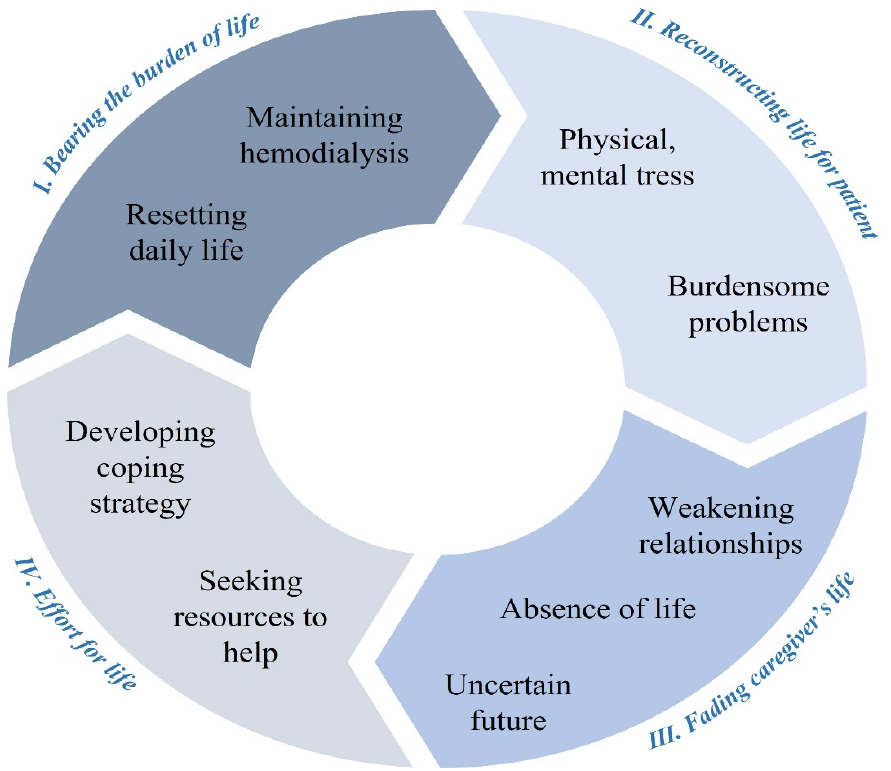
Figure 2. Conceptual model of the experience of a caregiver caring for patients with HD.